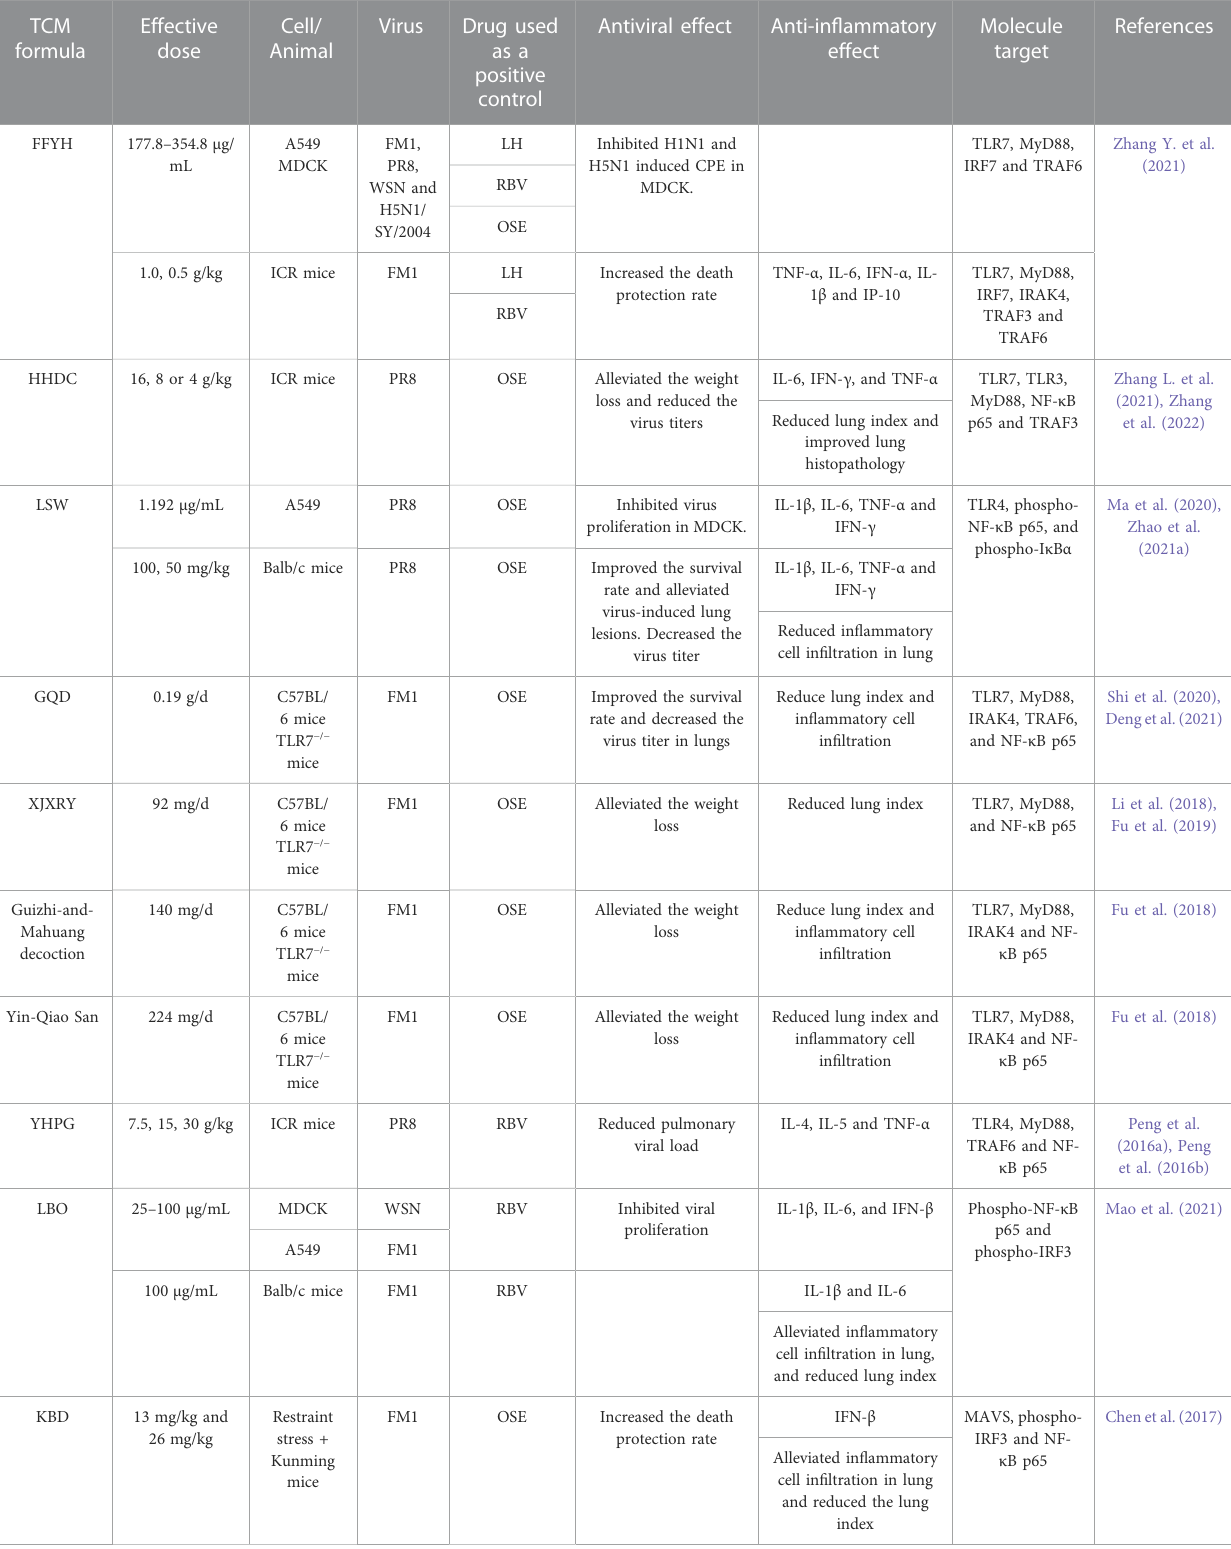
TABLE 1 The effects of TCM formulae on PRRs-mediated activation of NF- κ B induced by in fl uenza virus